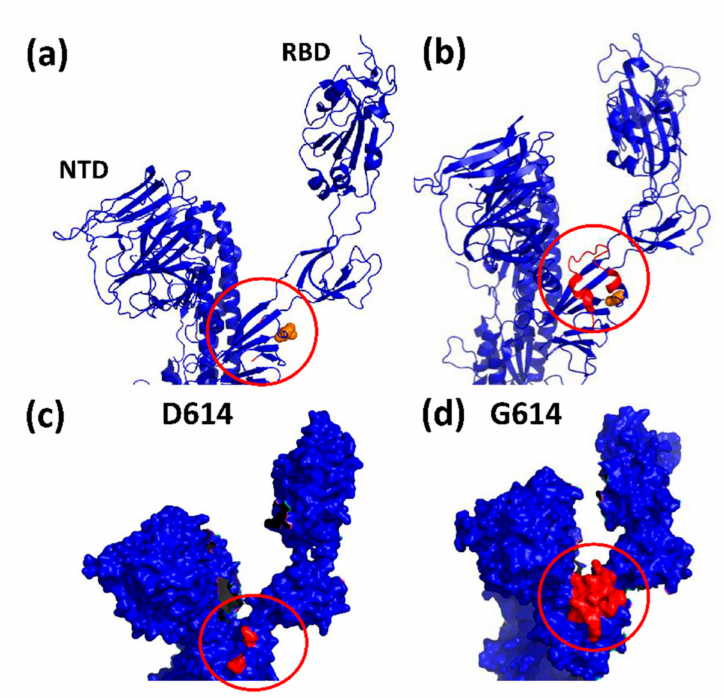
Figure 3. Structural impact of the D614G mutation. ( a ) Cartoon rendering of the open spike protomer (only top half is shown) with an aspartate at position 614 (D614, orange spheres); the disordered 620–640 loop (red circle) is absent from the structure; NTD (N-terminal S1 domain); RBD (receptor binding domain in S1) (PDB: 7KRR); ( b ) Cartoon rendering of the open spike protomer with a glycine at position 614 (G614, orange spheres) (PDB: 7DK3); the ordered 620–640 loop (red) is now visible; ( c ) Surface rendering of spike D614; ( d ) Surface rendering of spike G614. Visualisation with PyMOL (Molecular Graphics System, Version 2.0 Schrödinger,